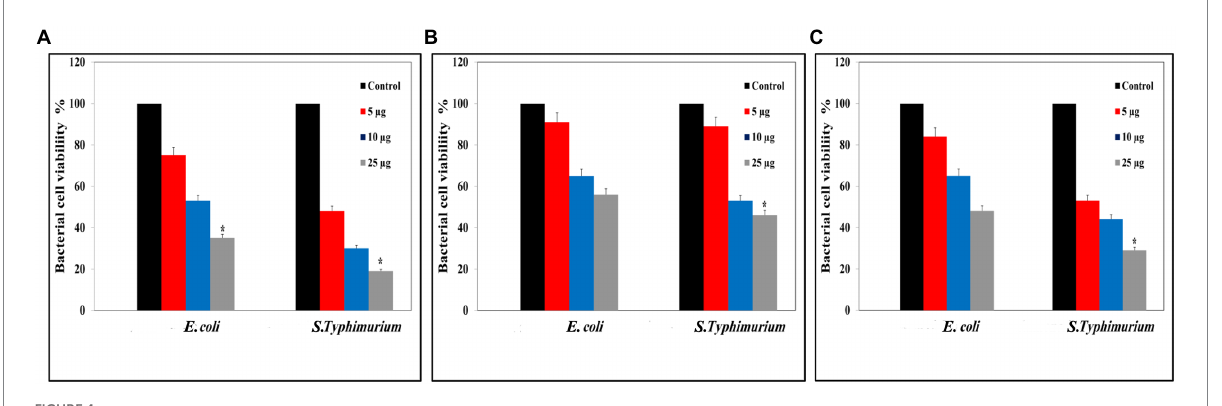
FIGURE 4 Colony Forming Unit (CFU) assays: (A) CFU of Silver magnetite core shell nanoparticle against Escherichia coli and Salmonella typhimurium. (B) CFU measurements of magnetite nanoparticle against E. coli and S. typhimurium . (C) CFU measurements of silver nanoparticle against E. coli and S. typhimurium . * p < 0.05 was considered a statistically significant difference.